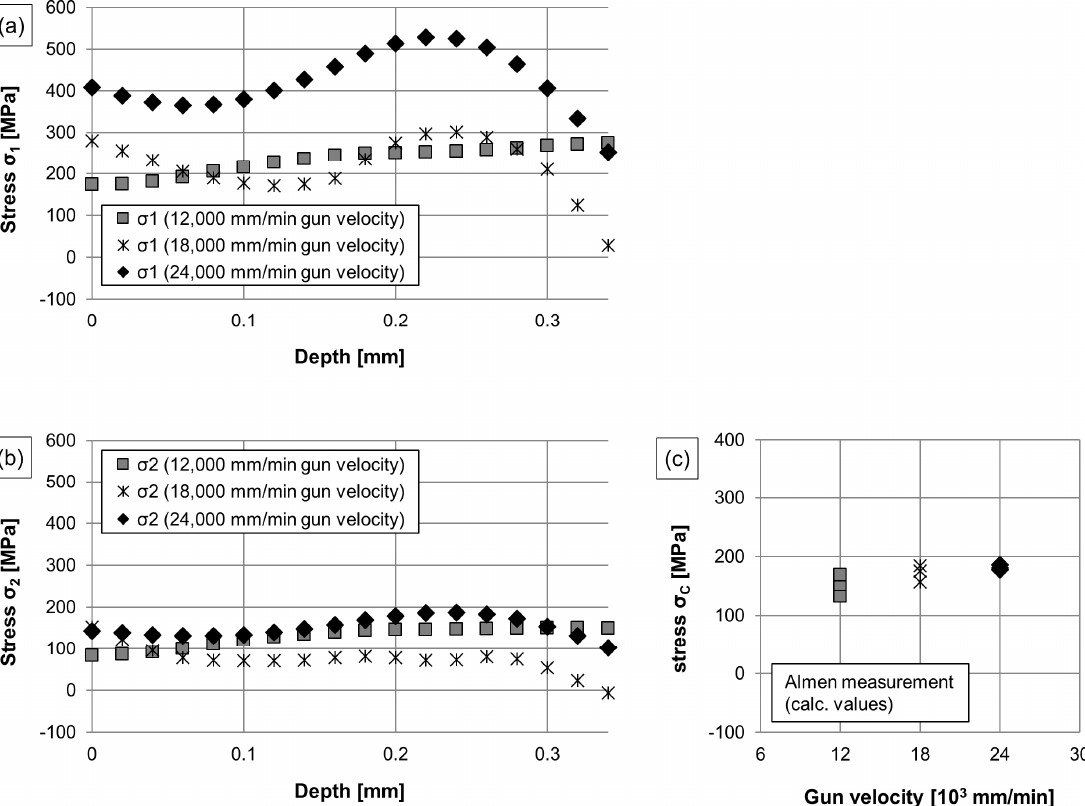
Figure 8. Residual stress distribution along coatings produced with different gun velocities determined by using the bore hole drilling strain gage method ( a , b ) (coating thickness: 330 ± 19 μ m, 261 ± 20 μ m, and 182 ± 18 μ m, for 12,000, 18,000, and 24,000 mm/min, respectively), and calculated stress state in coatings produced with different gun velocities using the curvature method ( c ).